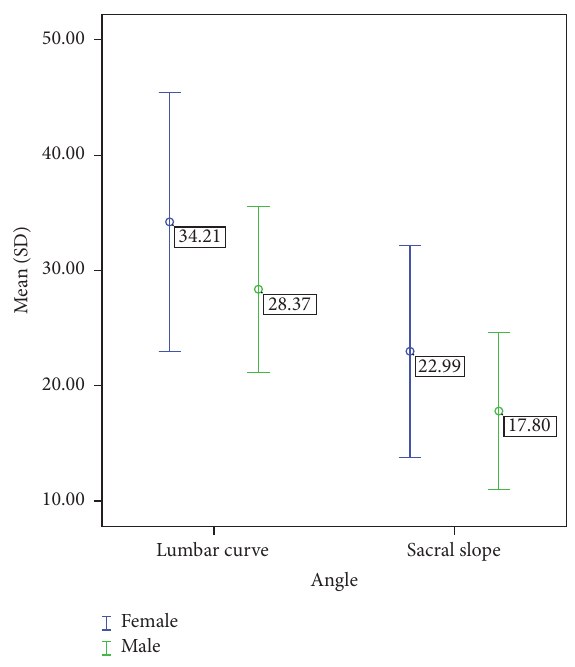
Figure 5: Between-gender differences (mean ± 1SD) separately for lumbar curve and sacral slope.